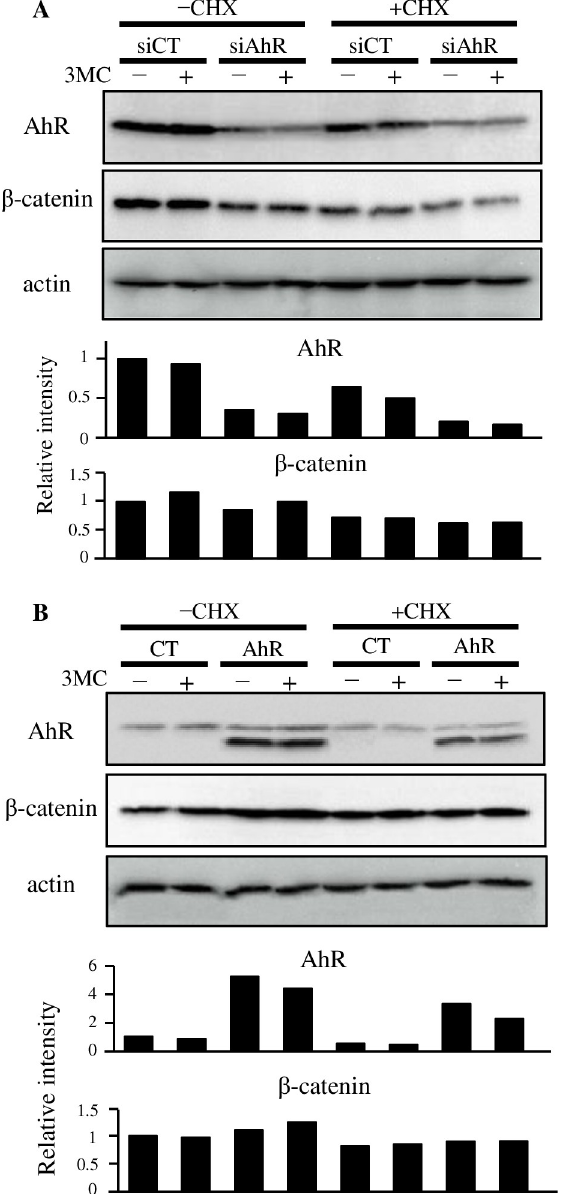
Fig 5. Alteration of β -catenin expression via AhR overexpression and knockdown. A ) HCT116 cells were transfected with AhR (siAhR) or control (siCT) siRNA. Following 36 hours of transfection, cells were exposed to a combination of 3MC (1 µ M) and CHX (100 µ M), and whole cell lysates were extracted after 6 hours. B ) Cells were transfected with a murine AhR expression vector pCI-mAhR or an empty vector pCI-neo. After 16 hours of transfection, cells were exposed to a combination of 3MC (1 µ M) and CHX (100 µ M), and whole cell lysates were extracted after 6 hours. Aliquots of the cell lysates containing 20 µ g proteins were subjected to western blotting with AhR (upper panel), β -catenin (middle panel) or actin antibodies (lower panel). The relative intensity is shown in the bottom of the panel. The intensity of the AhR signal represents the sum of the values obtained from the two bands. The upper band corresponds to endogenous human AhR and the lower band corresponds to the overexpressed mouse AhR. human steroid coactivator-1 (SRC-1), a typical nuclear receptor coactivator, instead of β -cate- nin [29]. Unlike β -catenin, SRC-1 enhanced transcriptional activity by binding to the transac- tivation domain of AhR but not to the acidic domain alone (S2 Fig).